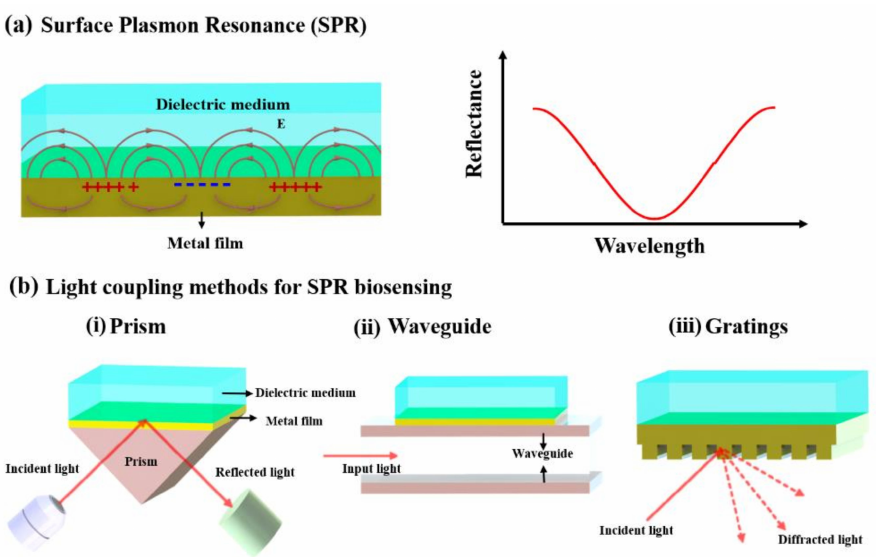
Figure 2. Schematic representations of ( a ) surface plasmon resonance (SPR) at a flat metal–dielectric interface. ( b ) The excitation of surface plasmon–polariton by different light coupling methods for SPR biosensing, including ( i ) by prism coupling-based Kretschmann configuration, ( ii ) by the optical wave-guide coupling, and ( iii ) by light diffraction grating